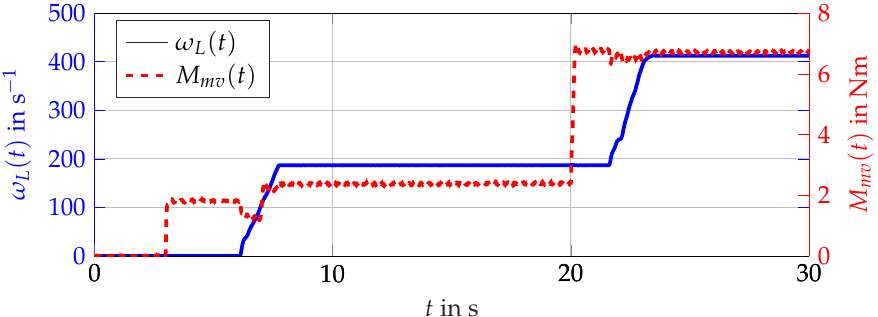
Figure 12. Scenario given by measurement data obtained at the test bench. Measured torque M mv ( t ) (red, dashed) and angular velocity ω L ( t )